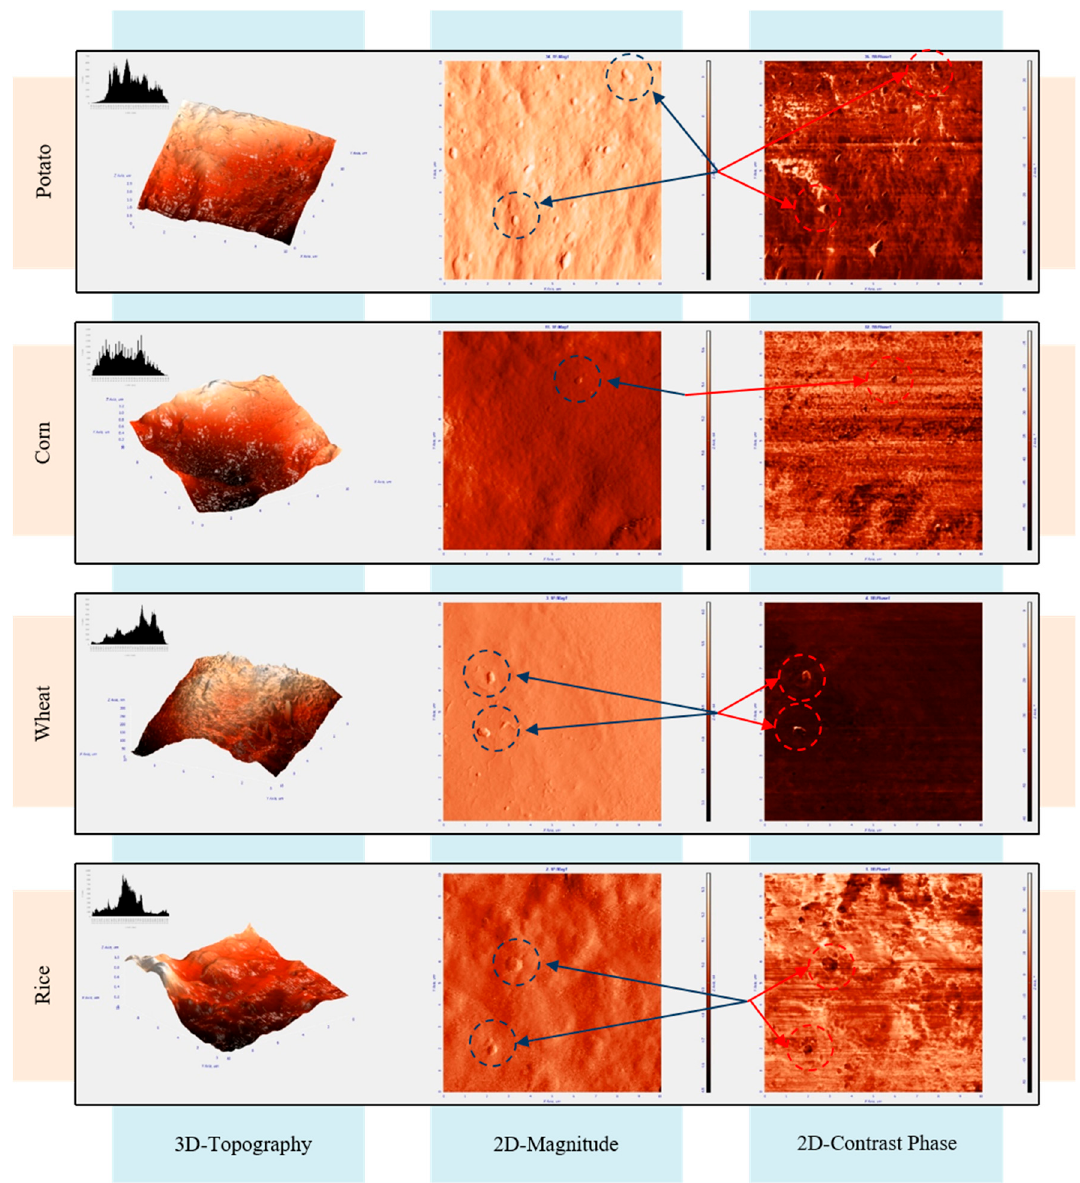
Figure 5. AFM three- and bi-dimensional topographic images and bi-dimensional contrast phase images of the surface of potato, corn, wheat, and rice films.